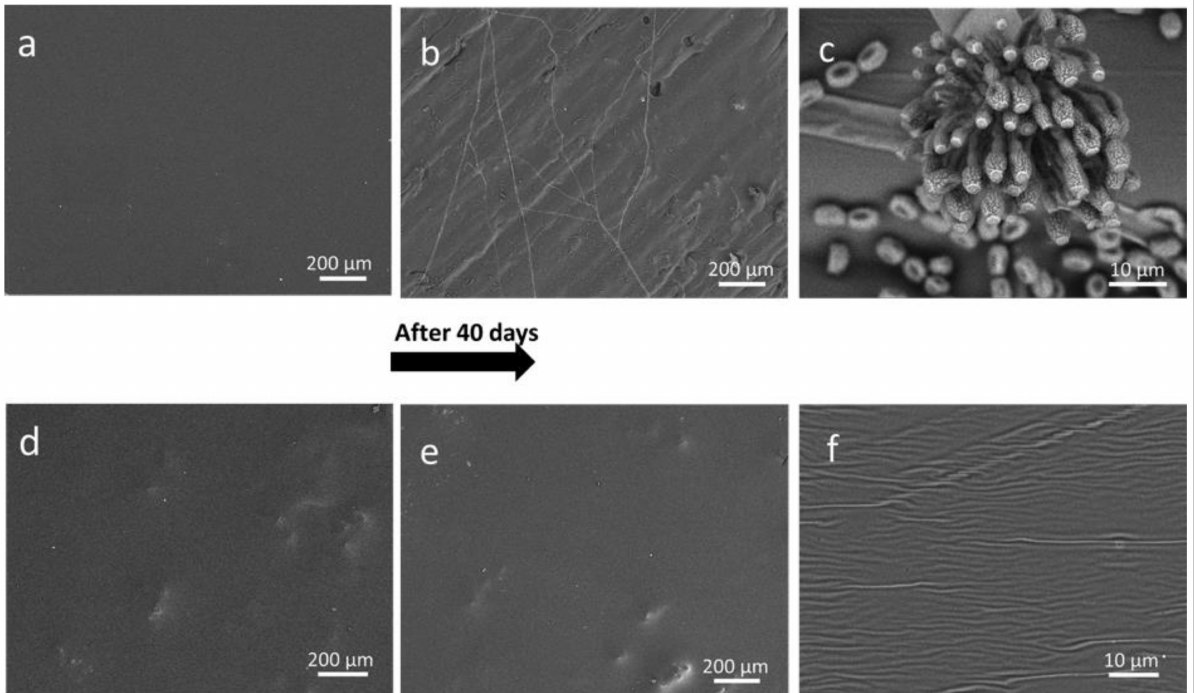
Figure 7. SEM micrographs taken on the surface of treated wood specimens during the fungi test: ( a ) SH before test; ( b ) SH after 40 days; ( c ) higher magnification of ( b ); ( d ) ZnO-ES-SH before test; ( e ) ZnO-ES-SH after 40 days; ( f ) higher magnification of ( e